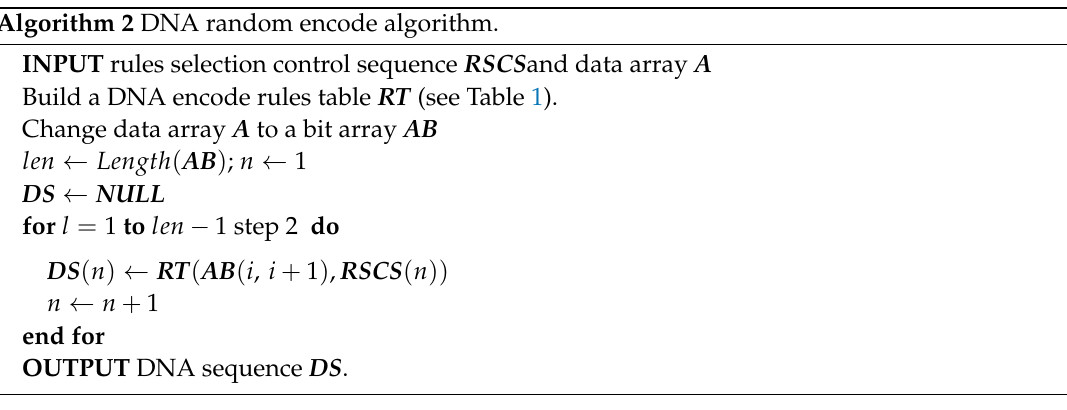
Algorithm 3 Generation algorithm of permutation control sequence (PCS). INPUT image DNA sequence IDS and initial key